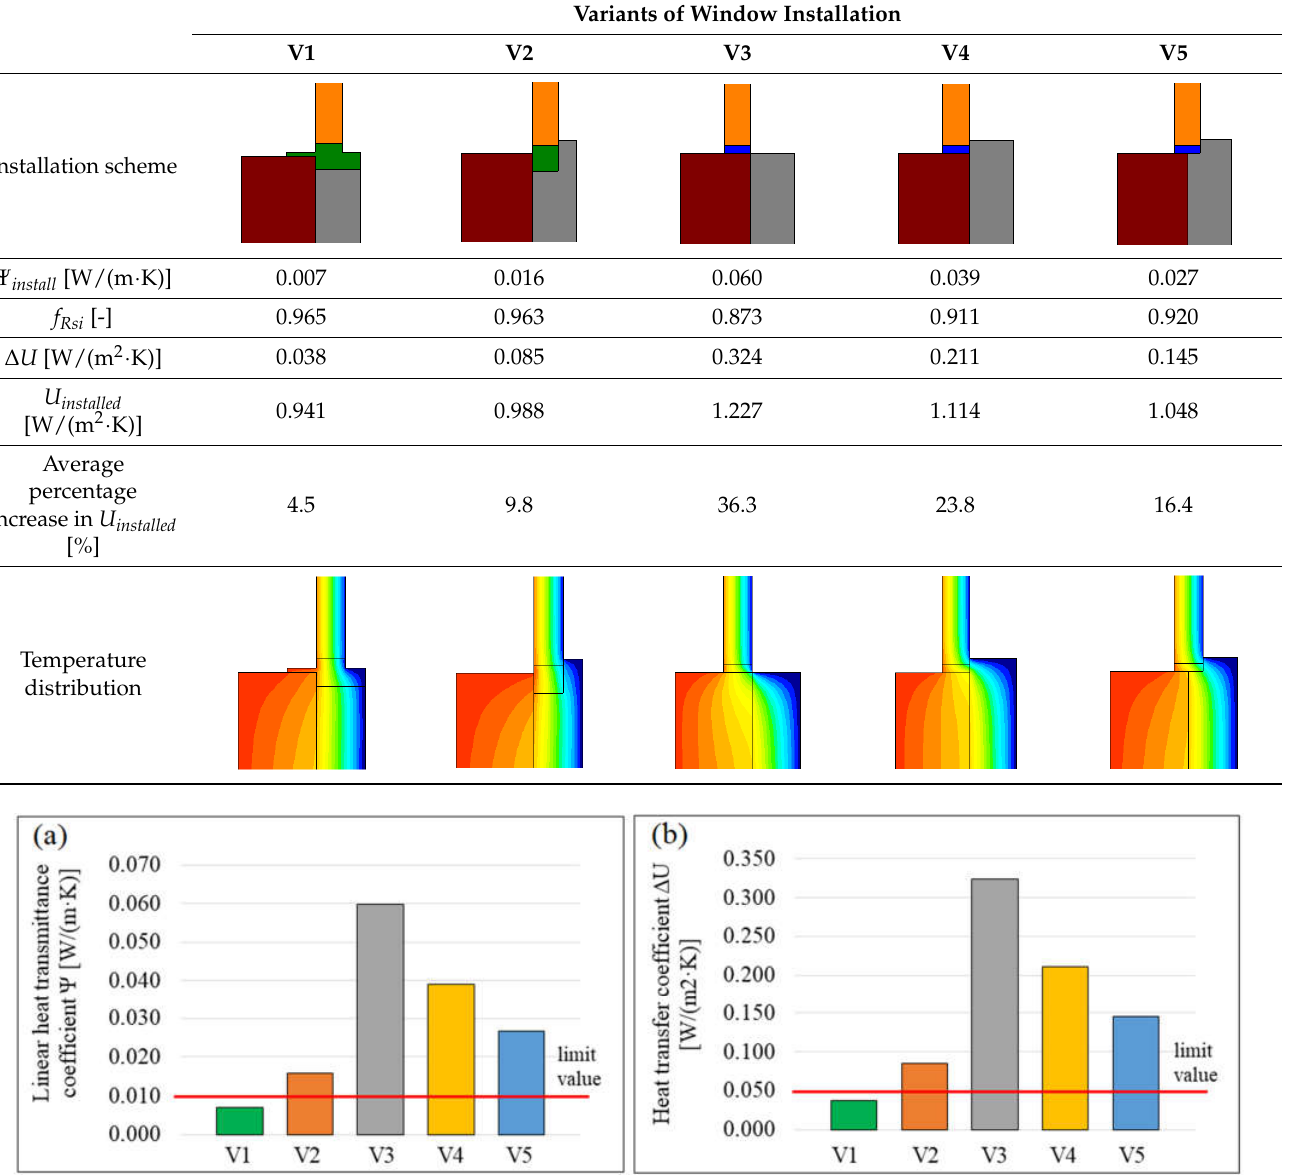
Figure 12. Comparison of: ( a ) linear heat transmittance coefficient ψ, ( b ) heat transfer coefficient Δ U .